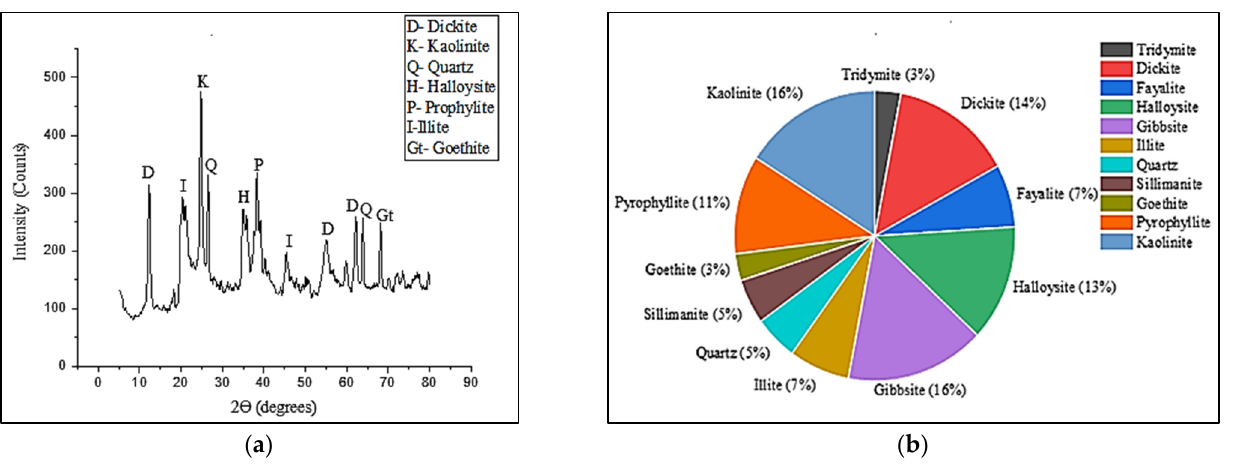
Figure 16. Characterization of minerals and compounds; ( a ) XRD analysis of Hemmadi sample, ( b ) quantification of